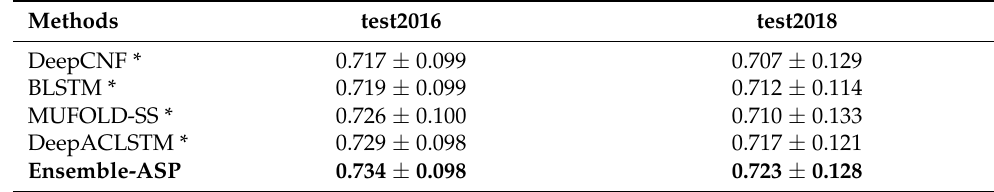
Table 7. The comparison between the Q8 results on SPOT-1D benchmark dataset (the mean and standard deviation measured over the proteins within each test set) of our method and the results of state-of-the-art methods.